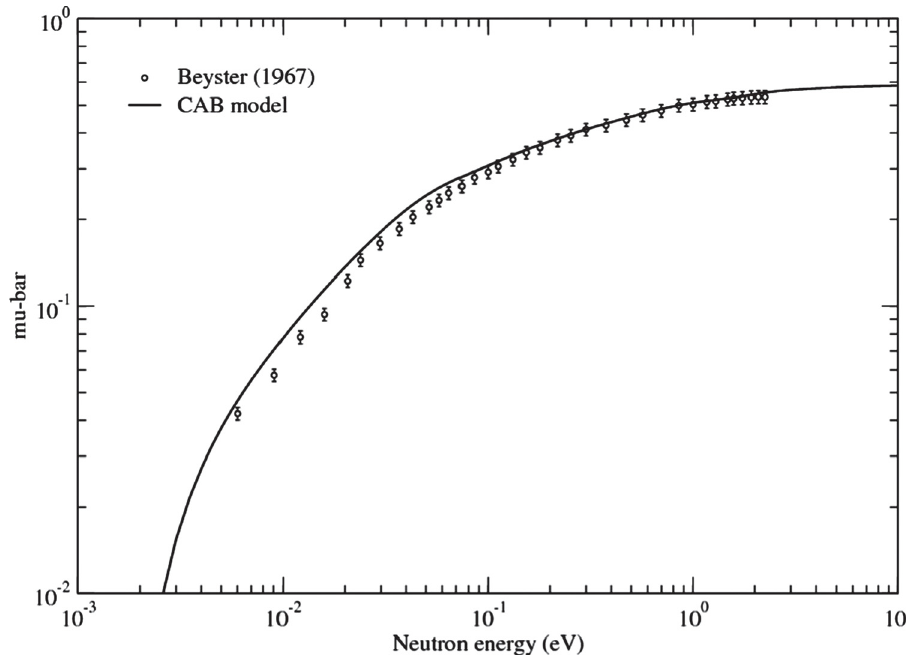
Fig. 2. Average cosine of the scattering angle calculated with the CAB model compared with experimental data at 294 K